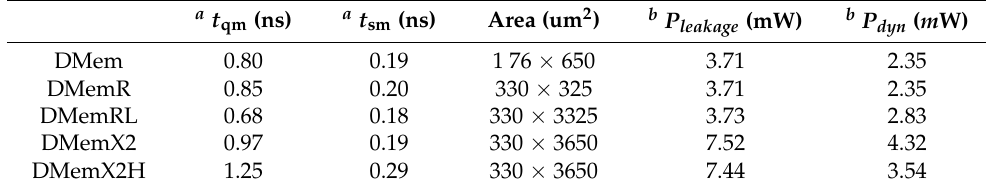
Table 2. Design metrics and comparison with existing